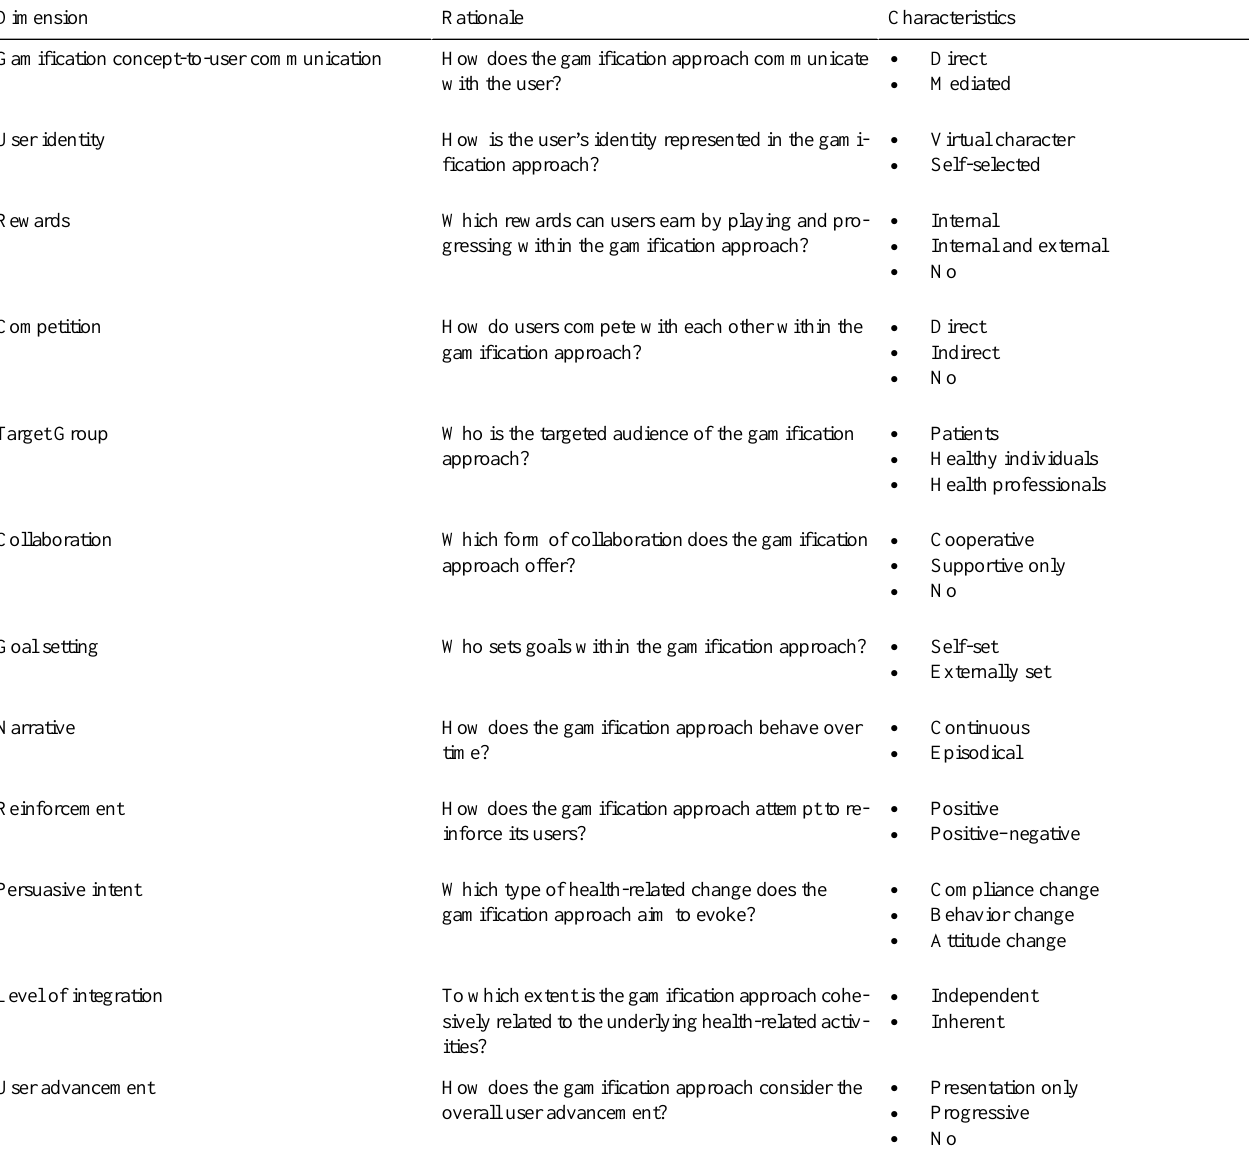
Table 1. Taxonomy of gamification approaches for health apps proposed by Schmidt-Kraepelin et al